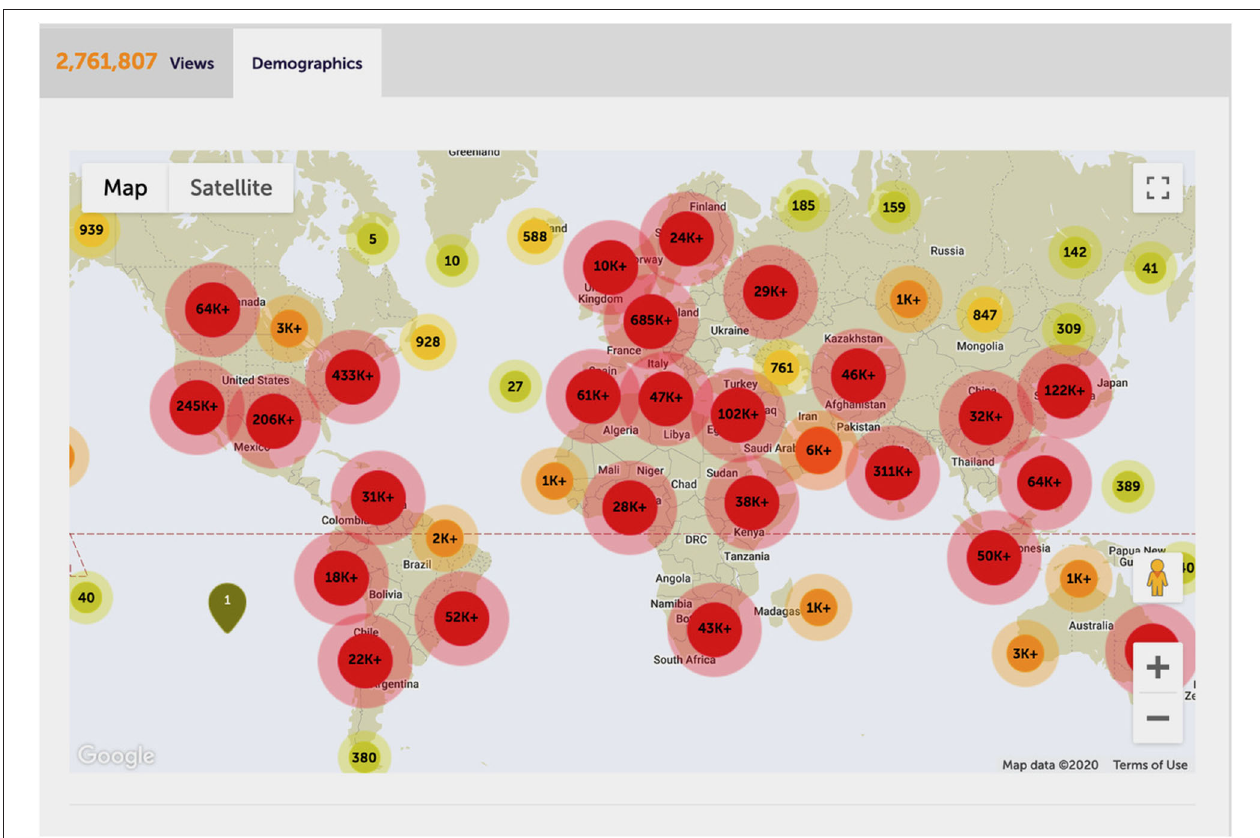
FIGURE 2 | The most-viewed COVID-19 Frontiers research topic. Global impact and demographics of the most-viewed Frontiers research topic on COVID-19 (https://www.frontiersin.org/research-topics/13377/coronavirus-disease-covid-19-pathophysiology-epidemiology-clinical-management-and-public-health-resp# impact), overall attracting about 2.8 million views as per 1 October 2020. With permission of Frontiers. Data and carton was reproduced from the Frontiers website.